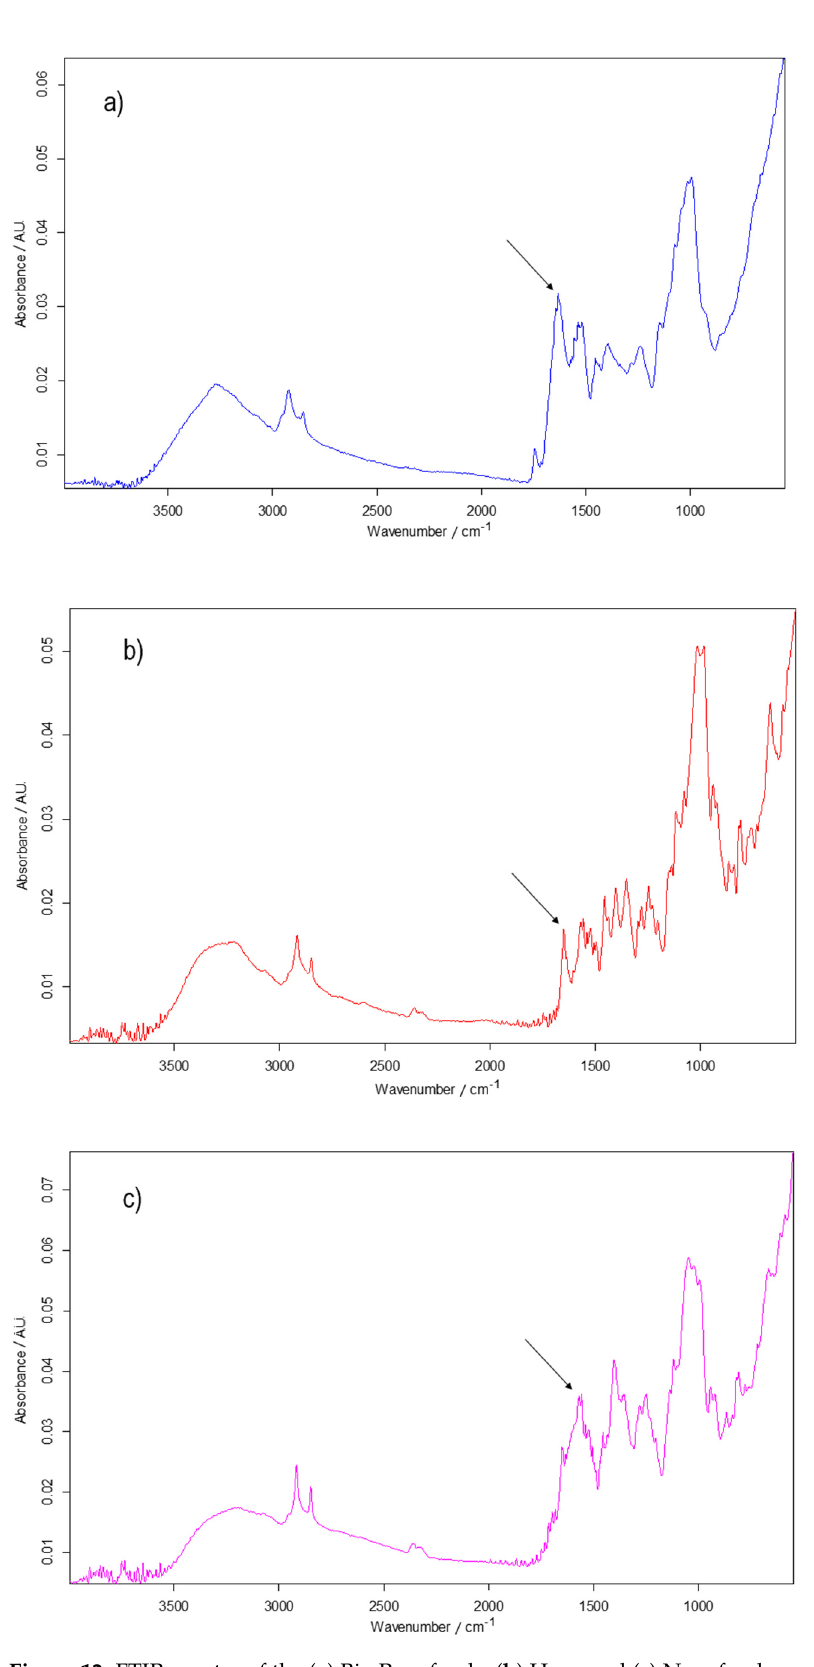
Figure 12. FTIR spectra of the ( a ) Bio Raw foods, ( b ) Haya and ( c ) Now foods samples.